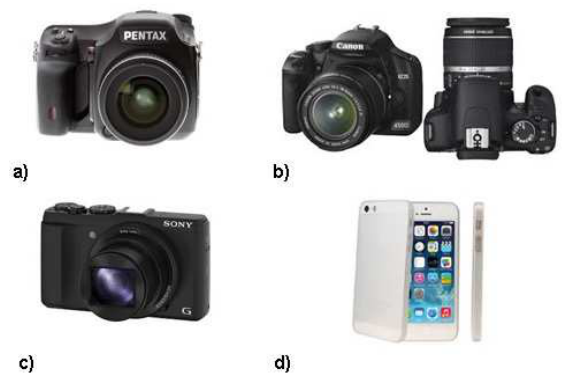
Figure 2. Tested cameras: a) Pentax 645D; b) Canon EOS